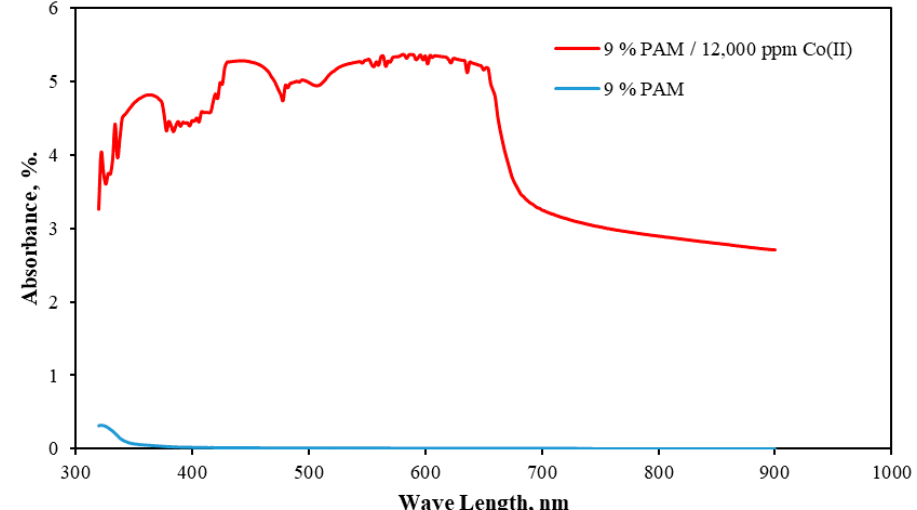
Figure 8. Ultraviolet-visible spectroscopy (UV-Vis) analysis of 9 wt.% PAM and 9 wt.% PAM/12,000 ppm Co (II) mature gel.